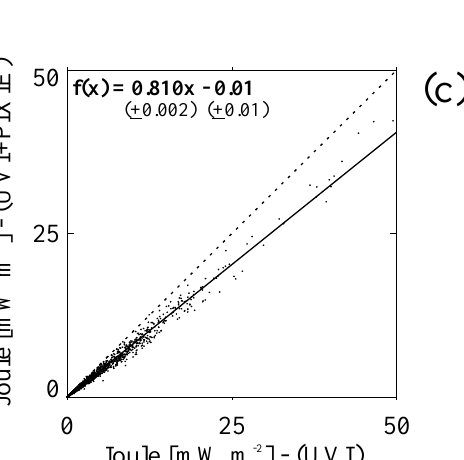
Fig. 12. (a) Hall conductances 6 H , (b) Pedersen conductances 6 P and (c) Joule heating values Q J derived with and without the PIXIE data throughout the time interval between 02:00 and 04:20 UT on 31 July 1997. The data values are taken from the regions covered by the PIXIE and UVI instruments. The solid line results from a linear regression analysis of the data